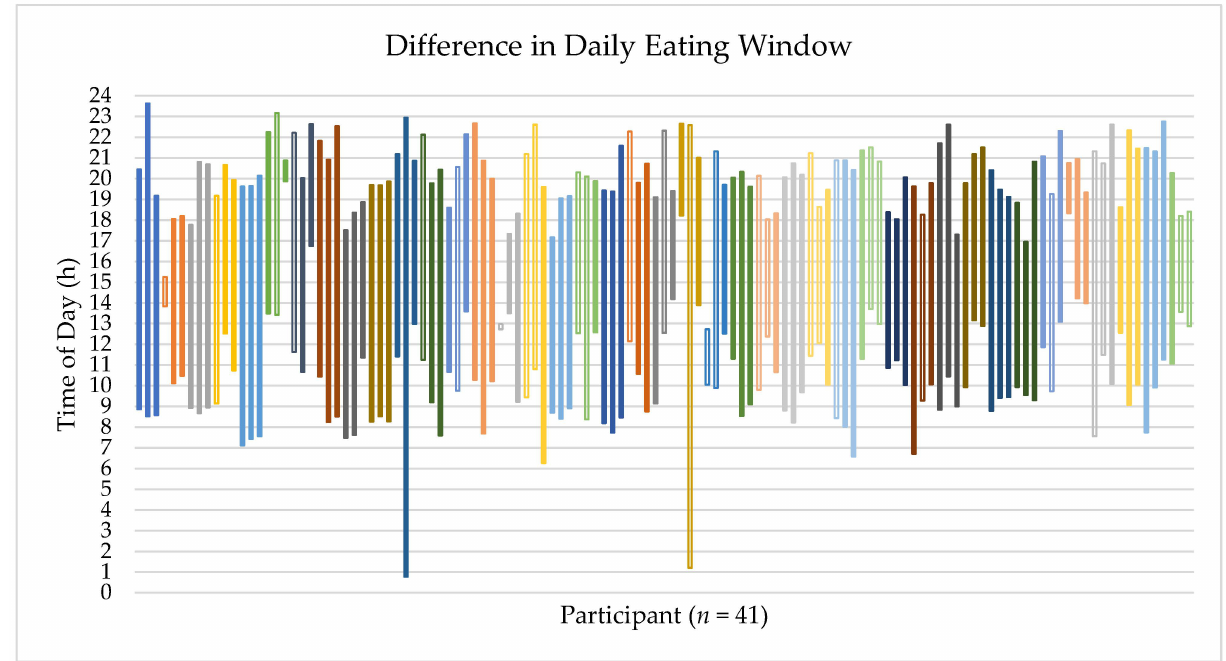
Figure 1. Individual differences in eating window (time from the first eating occasion of the day until the last eating occasion of the day). Each color represents a separate participant. Each column represents one day. Solid columns represent weekdays and unfilled columns represent weekend